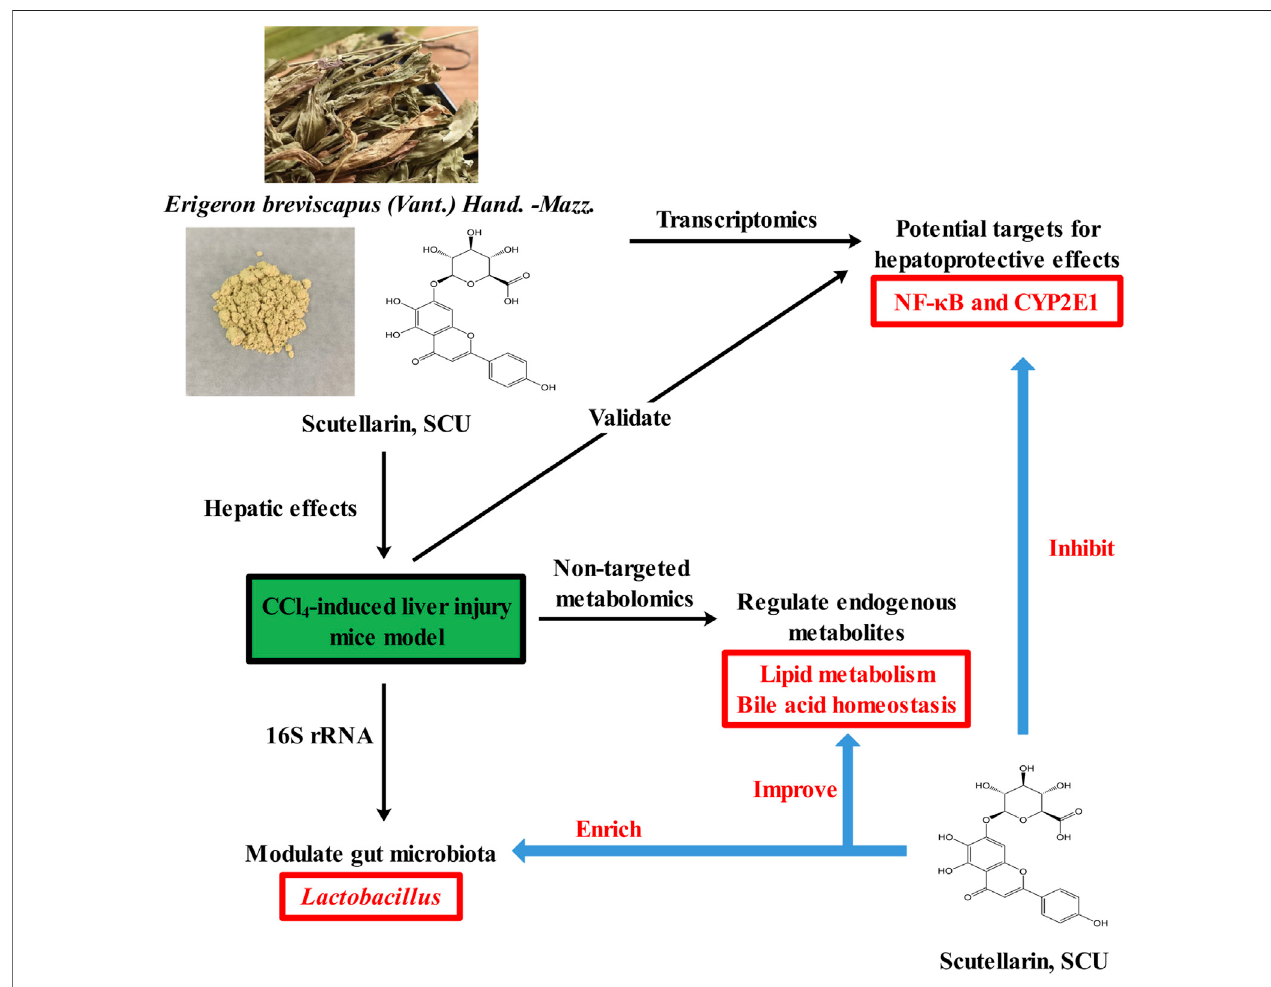
FIGURE 5 | Graphical abstract of protective property of scutellarin against liver injury induced by carbon tetrachloride in mice.